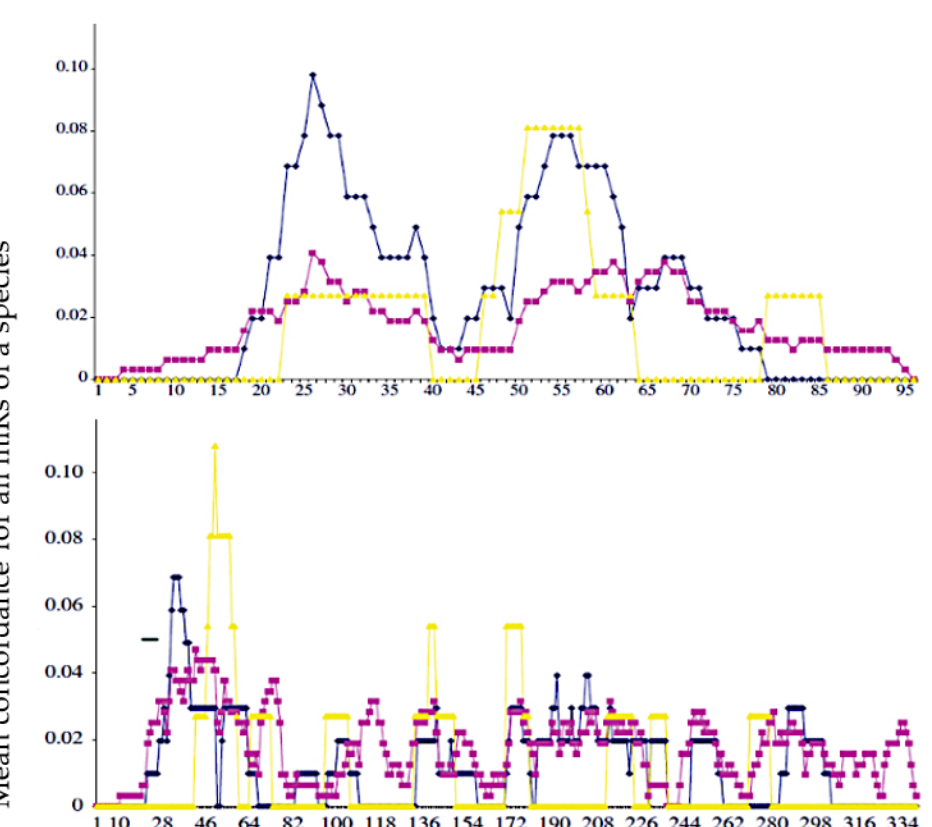
Figure 5. Mean concordance (in %) between the sequences of the miRs of the 5 ’ -UTR part (UnTrans- lated Region) of the host genome (blue for G. gallus and purple for H. sapiens), vector genome (yellow for A. gambiae) and a sequence at the top, of West Nile virus (WNV) UTR genome and at the bottom, of hepatitis C virus (HCV) UTR genome (from [43]).